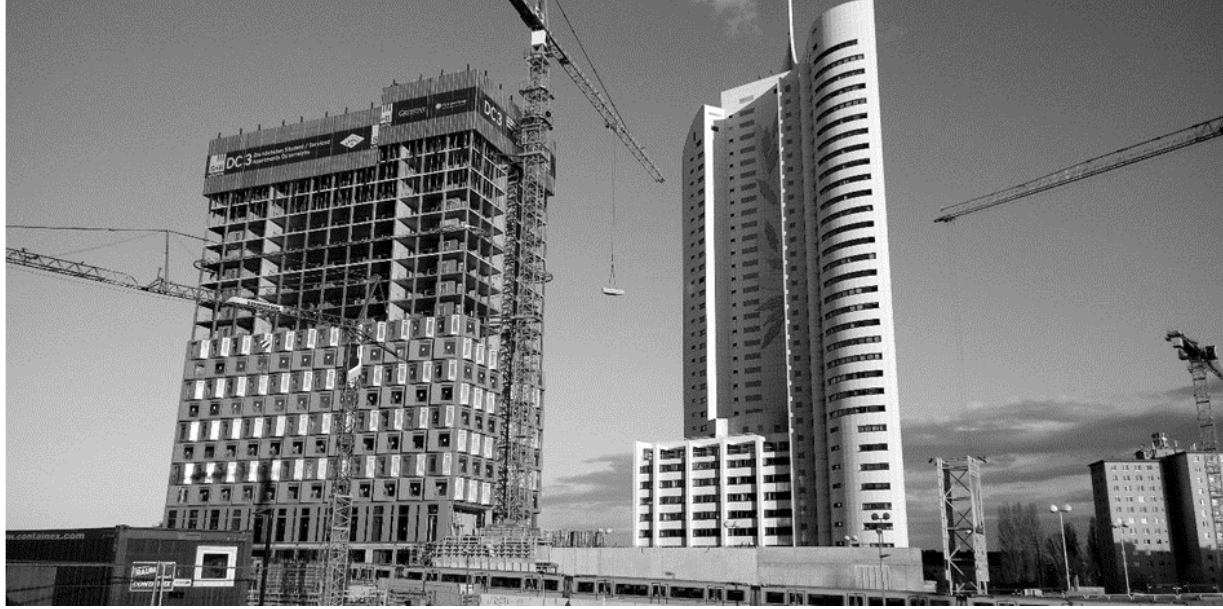
Figure 3. Student accommodation under development and a high‐rise building promoted as the tallest student apartment building by an FP investor in Vienna. Source: Photograph taken by Elisabeth Gruber,